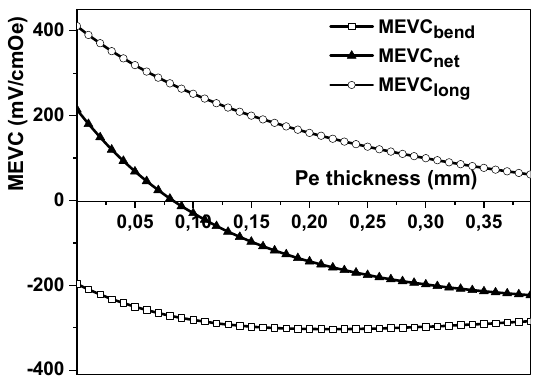
Figure 9. Estimated dependence of MEVC in a Ni-Permendur-PZT second-type three-layered structure on the Permendur layer thickness. The PZT layer thickness t p = 0.2 mm, the Ni thickness t m 1 = 0.2 mm.